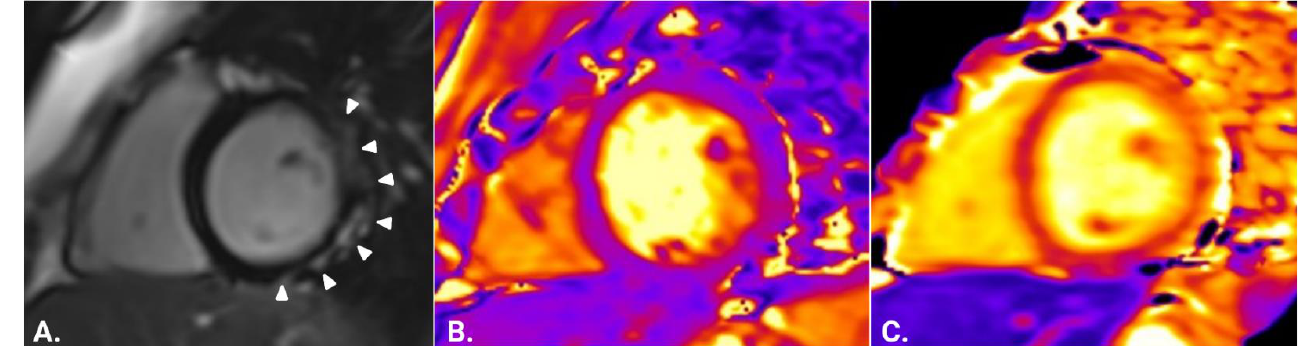
Figure 4. Representative cardiovascular magnetic resonance findings in a patient with Duchenne muscular dystrophy. ( A ) Short-axis inversion recovery imaging shows subepicardial fibrosis in the inferolateral wall of the left ventricle (arrowheads) (5% of left ventricular mass). ( B ) Short-axis T2 mapping of the same patient (average 45 ms). ( C ) Short-axis native T1 mapping of the same patient (average 1343 ms).